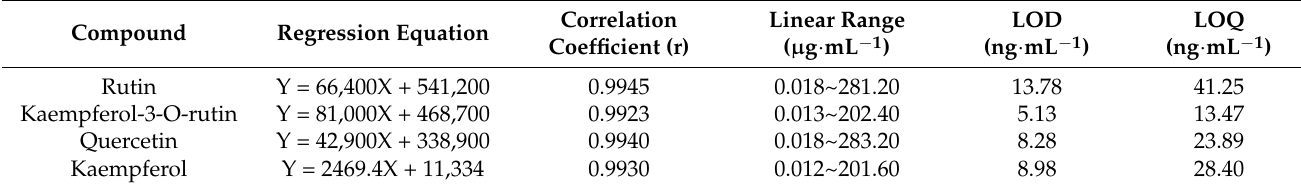
Table 6. The linear calibration curves of four compounds.